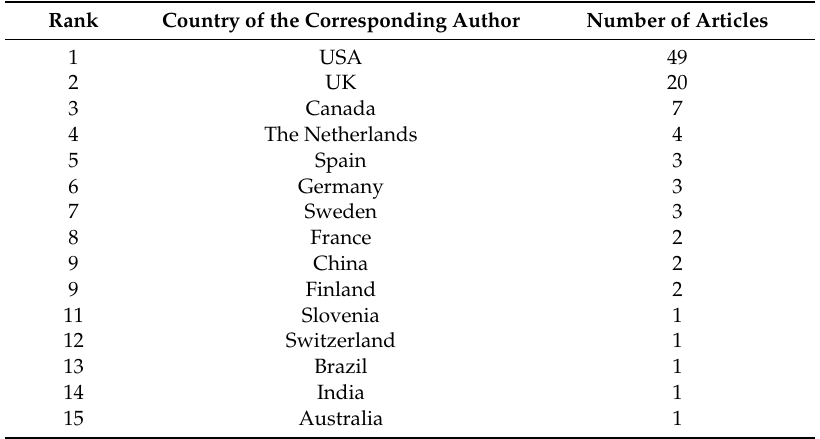
Table 3. Journals with top 100 articles, ranked according to the country of the corresponding